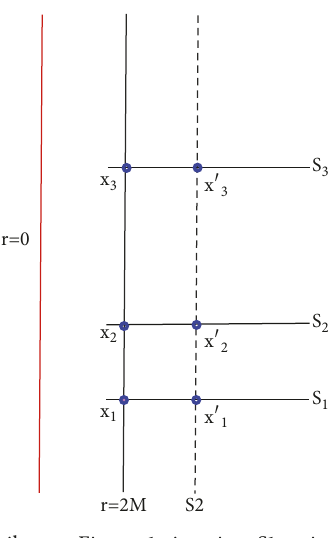
Figure 2: Similar to Figure 1, imagine 𝑆1 coincides with the horizon. The dotted line, 𝑆2 , is an artificial (nonphysical) timelike hypersurface in the vicinity of the horizon. Note that the blue dots 𝑥 𝑥 耠 푖 and 푖 are pairs of corresponding points, where and 𝑥 푖 , 𝑥 耠 푖 ∈ 𝑆 푖 . Also, ∑ 푖 𝑥 푖 ≡ 𝑆1 and ∑ 푖 𝑥 耠 푖 ≡ 𝑆2